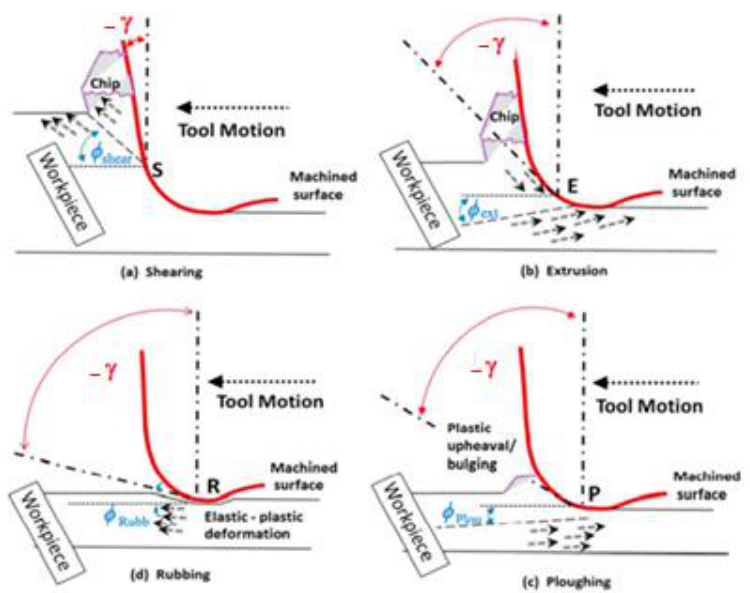
Figure 3. Material deformation mechanisms under effective varying rake angles: ( a ) shearing, ( b ) extrusion, ( c ) ploughing, and ( d ) rubbing [5].